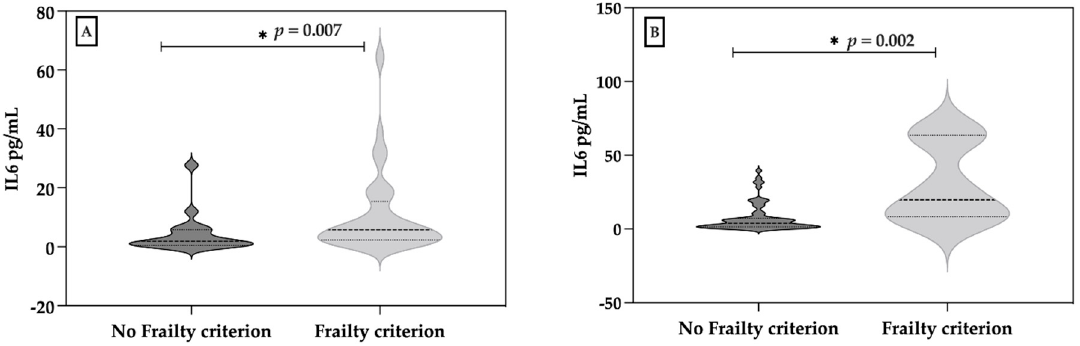
Figure 3. ( A ) Difference between physical activity frailty criteria and ( B ) IL-6 (pg/mL) and weight loss frailty criteria and IL-6 (pg/mL).